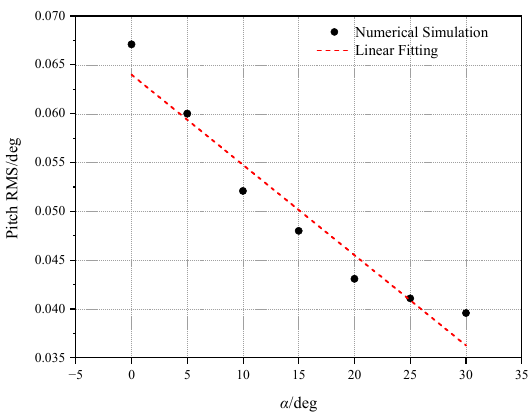
Figure 13. Pitch responses with different inclined angles.